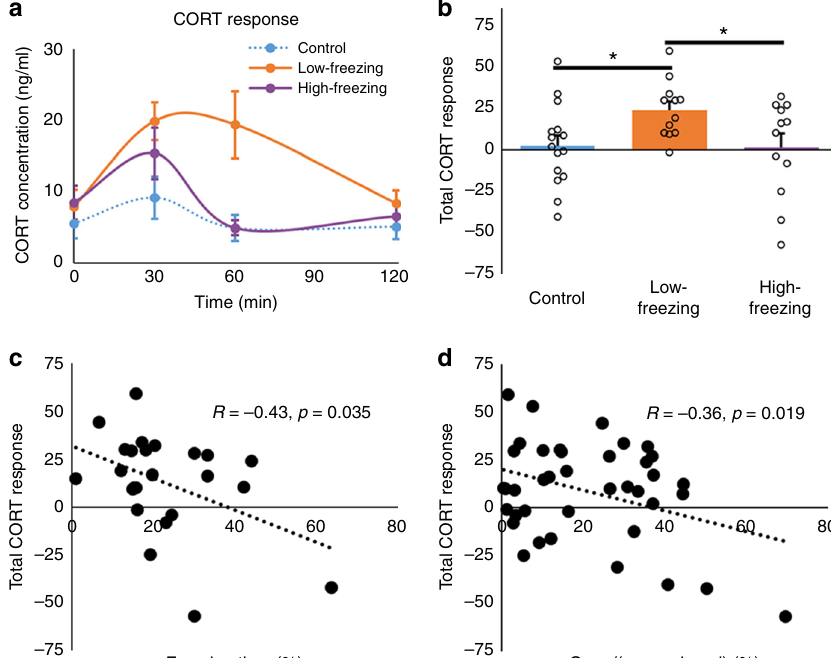
Fig. 3 Corticosterone (CORT) responses. a Time course of CORT (in ng/ml) for high-, low-freezing, and control animals. There was a signi fi cant difference in CORT level changes over time among three groups (Two-way repeated ANOVA, F group × time (6,108) = 2.84, p = 0.023). Control animals showed no appreciable CORT change across time (One-way repeated ANOVA, F time (3,56) = 0.8, p = 0.50). High-freezing animals exhibited a relatively short CORT response, peaking at 30 min and returning to baseline at 60 min (Tukey-Kramer test, 30 min vs. 60 min: p = 0.049; 0 min vs. 60 min: p = 0.54; 60 min